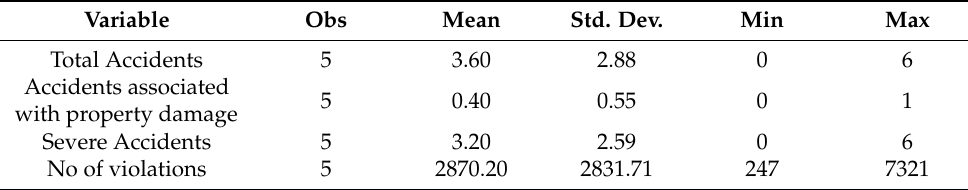
Table 3. Different intersection summary